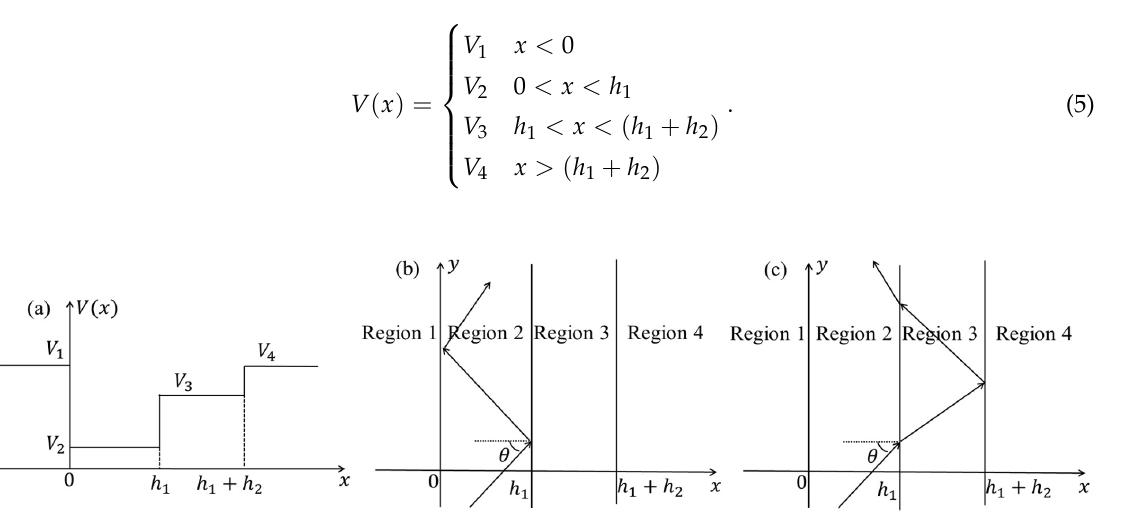
Figure 1. Schematic diagram of ( a ) a double-well potential on graphene; ( b ) guided modes in the region ( 0, h 1 ) ; ( c ) guided modes in the region ( 0, h 1 + h 2 )